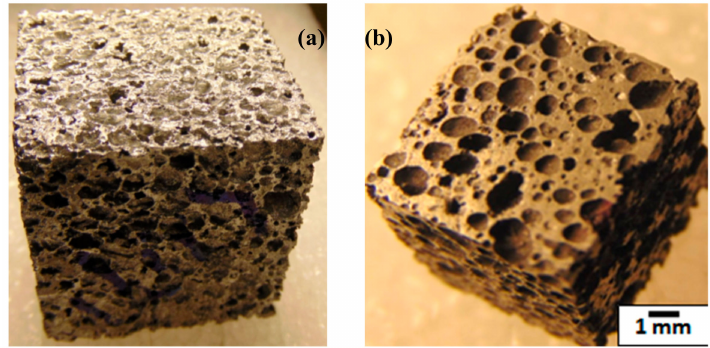
Figure 1. ( a ) Al foam block; ( b ) polished